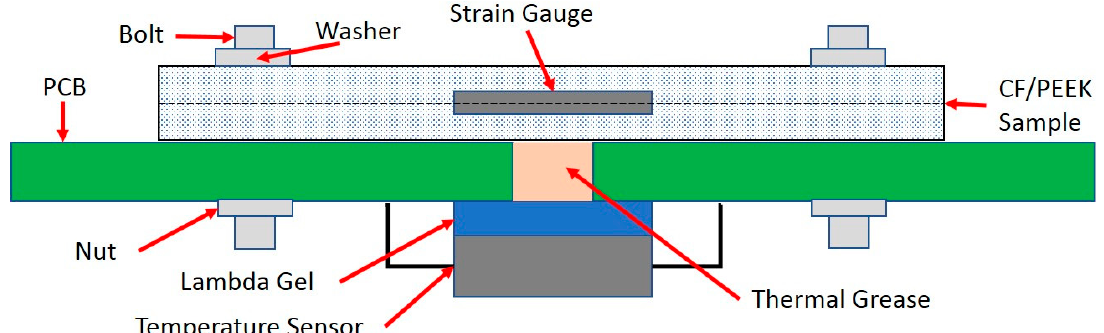
Figure 5. Cutaway of MM sample and temperature measurement system. The strain gauge is thermally welded between two CF / PEEK samples. Temperature is measured using a temperature sensor via heat conduction from the surface of the sample through a hole filled with thermal grease and α -gel.